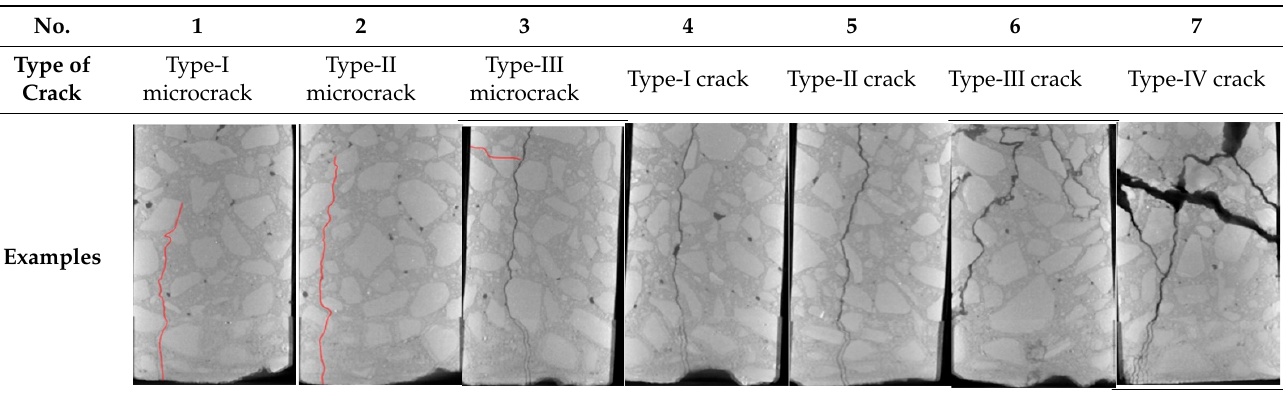
Table 3. Examples of particular types of cracks [126].